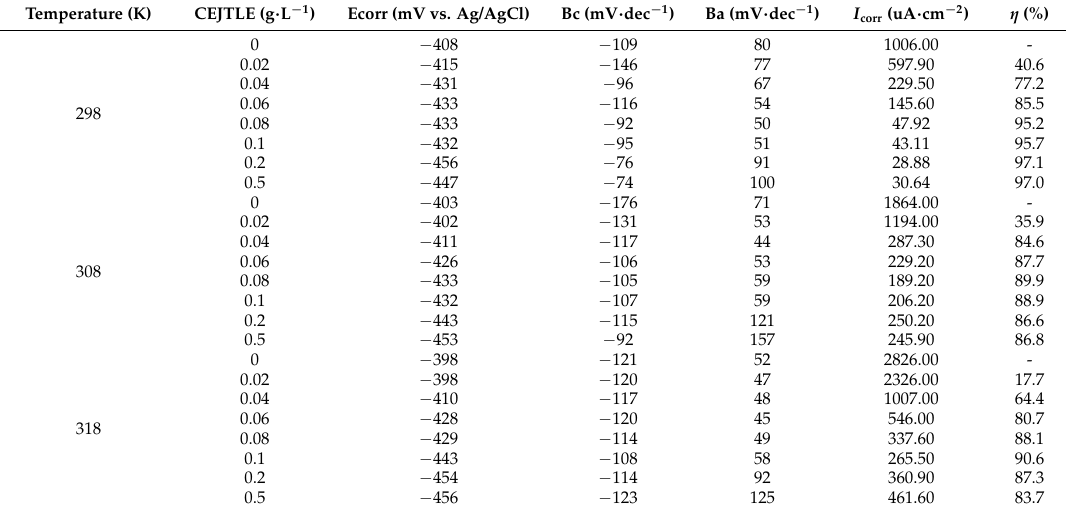
Table 1. Polarization parameters for C-steel in 1 M HCl solution with different concentrations of EJTLE at different